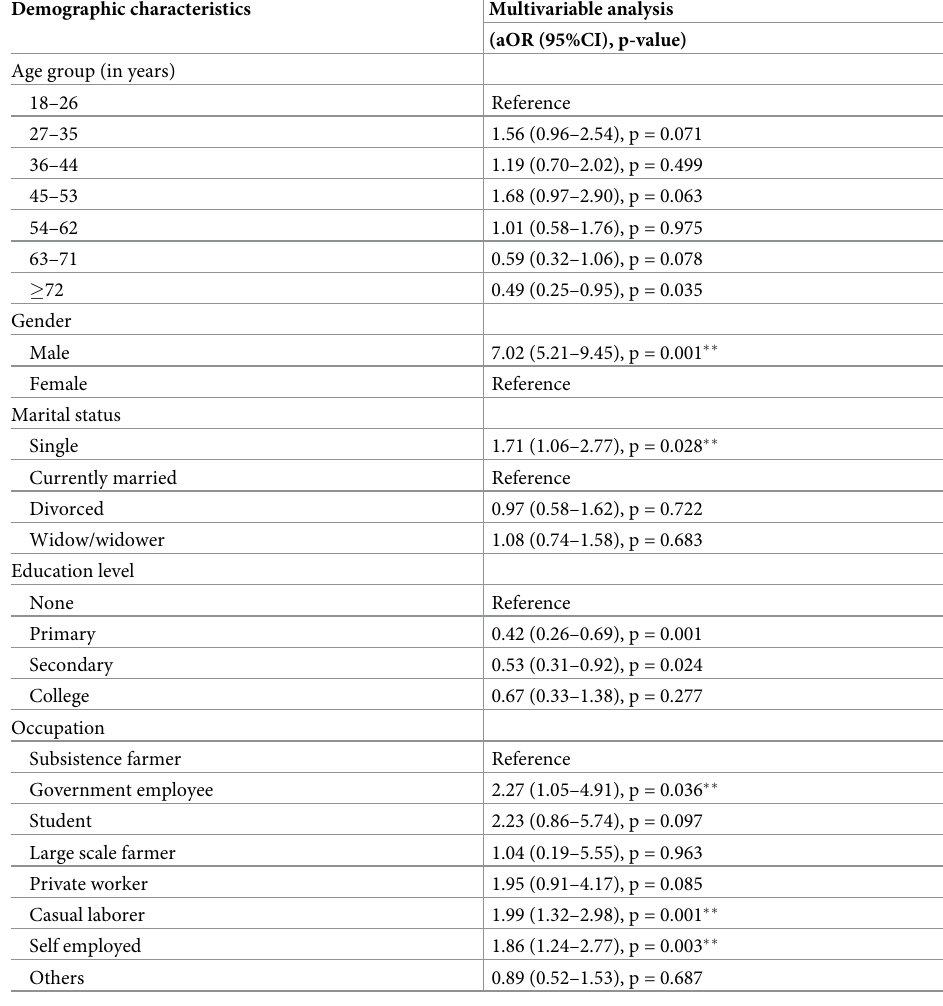
Table 5. Multivariable analysis of risk factors associated with any type of drugs and substances in